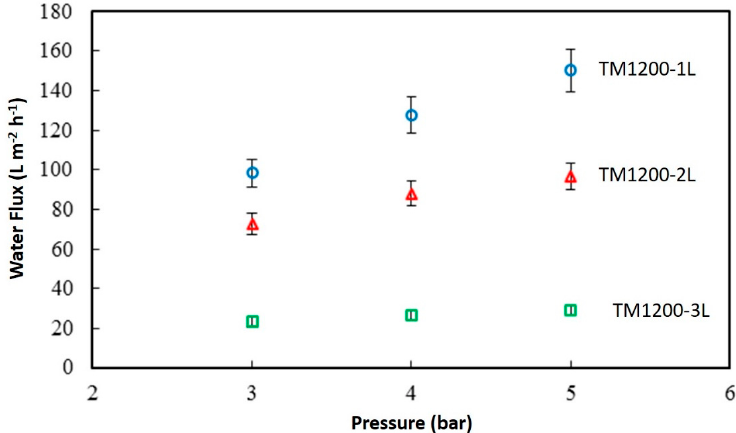
Figure 6. Water flux of the TM1200 membranes as a function of the feed pressure and number of layers.